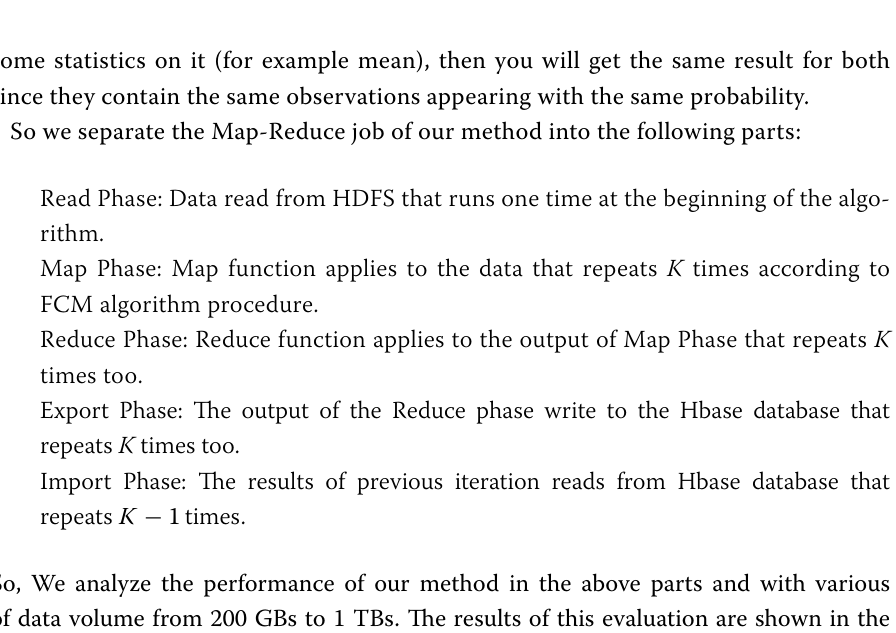
Table 7 Execution time (hour) of proposed method on 5 data nodes with huge volumes of data Size of data(GB) Read Phase